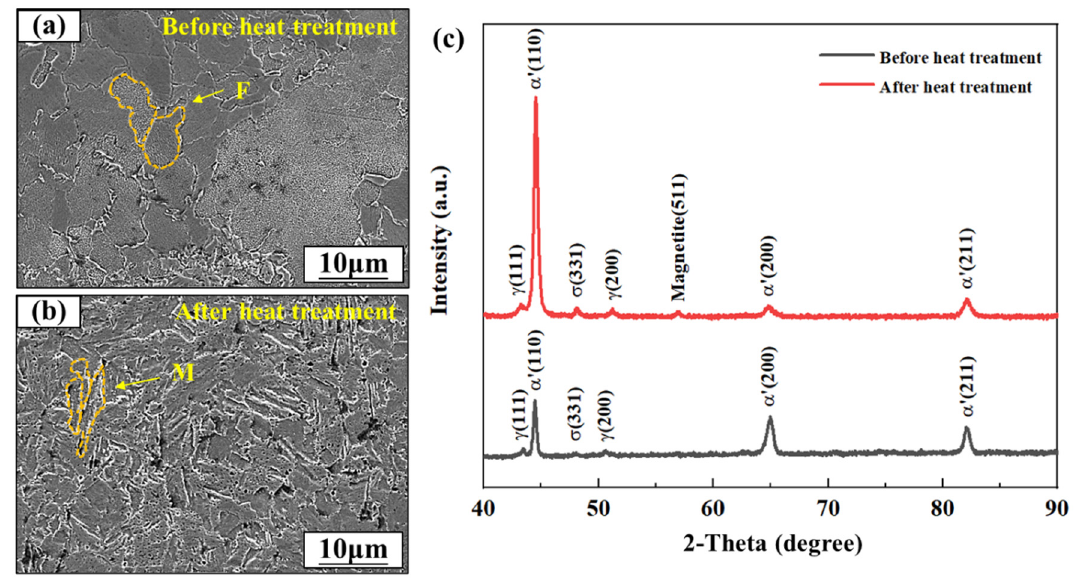
Figure 4. Microstructures of the SLM-ed 17-4PH SS ( a ) before and ( b ) after heat treatment. ( c ) XRD patterns of the SLM-ed 17-4PH SS before and after heat treatment.